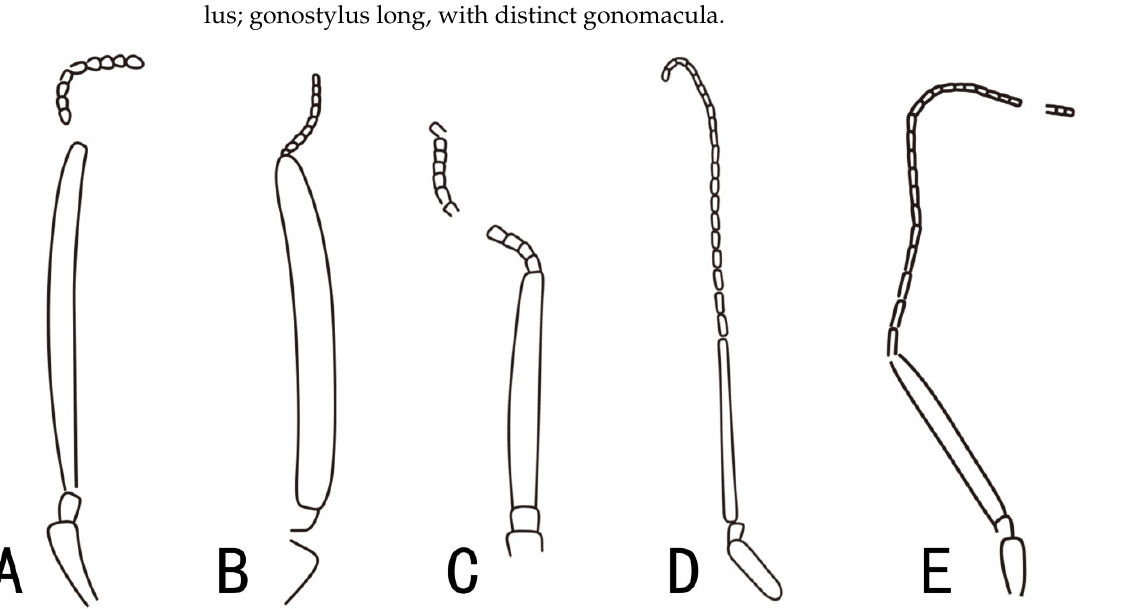
Figure 3. Angle of Rs+M and the section of Rs in the subfamily Macroxyelinae. ( A ), Uroxyela sicicauda , Rasnitsyn, 1966 (Xyeleciini). ( B ), Ceroxyela dolichocera , Rasnitsyn, 1966 (Ceroxyelini). ( C ), Leptoxyela eximia , gen. et sp. nov (Angaridyelini). ( D ), Megaxyela yaoshanic a, Zhang, 1989 (Macroxy- elini). ( E ), Sinoxyela viriosa , Zhang and Zhang, 2000 (tribe to be determined). ( F ), Abrotoxyela multi- ciliata , Gao, Ren and Shih, 2009 (Gigantoxyelini).